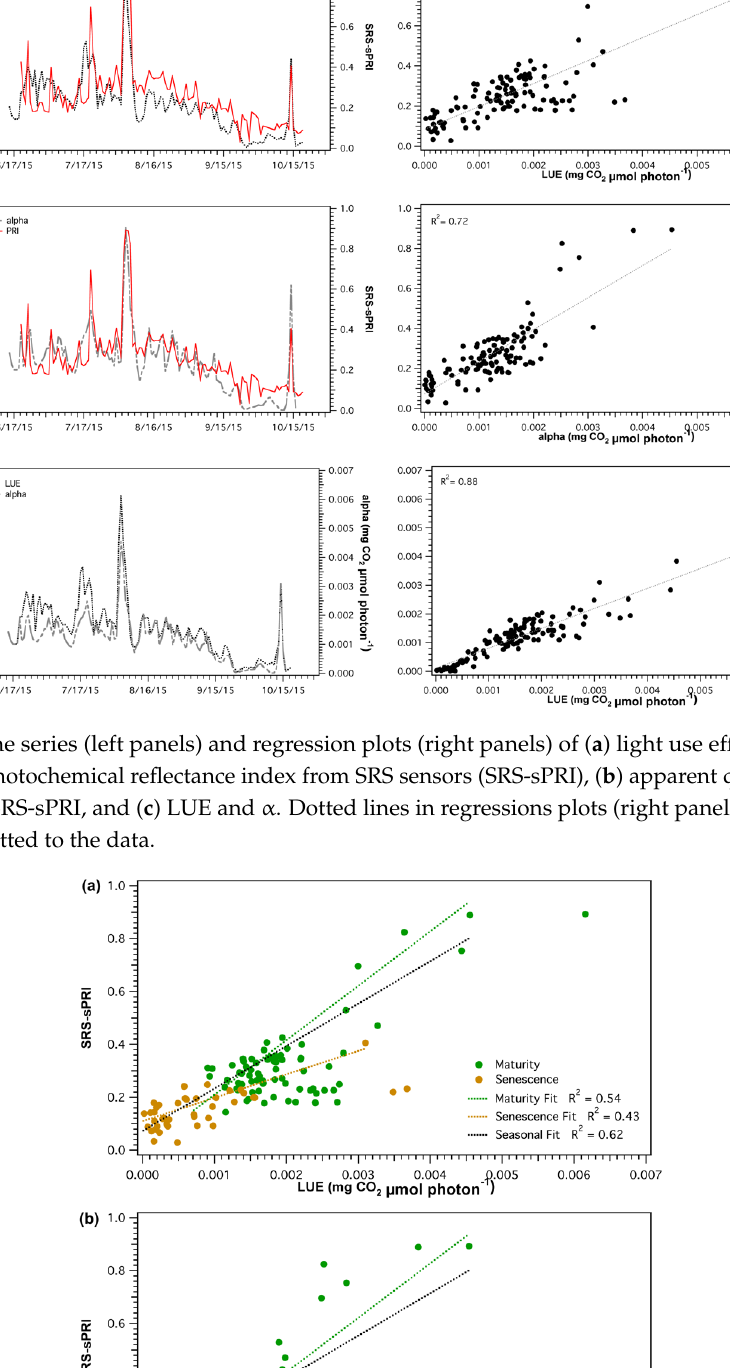
Figure 8. Seasonal (black), maturity (green), and leaf senescence (brown) correlations of scaled